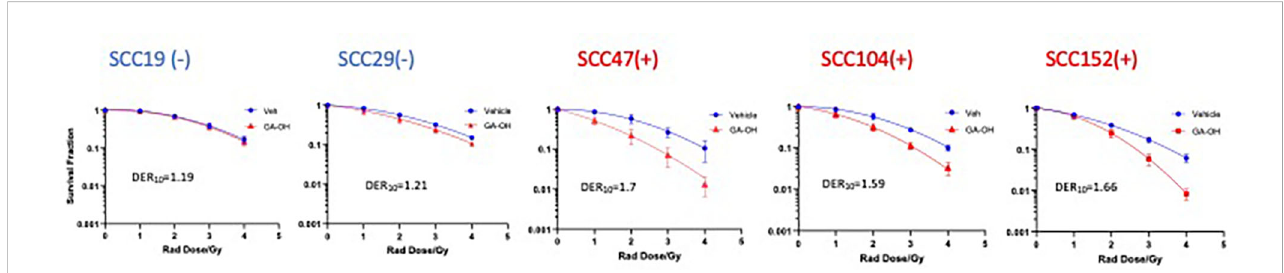
FIGURE 2 Sensitization of HNSCC cells to X-ray radiation combined GA-OH. HPV - (-) and HPV + (+) cells were treated with GA-OH (see Table S1 for concentrations) in combination with radiation (0-4Gy)). Colonies were counted after 14-21 days of incubation and normalized to controls. Survival analysis was performed using the linear quadratic model and GraphPad. GA-OH sensitization of radio cytotoxicity is biased more towards HPV + cells. Values shown represent means ± standard deviation from 3 independent